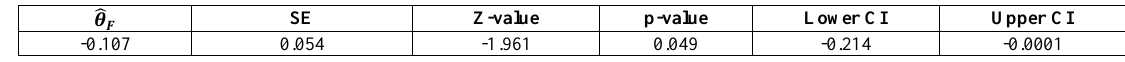
Table 2. Estimate for fixed effects